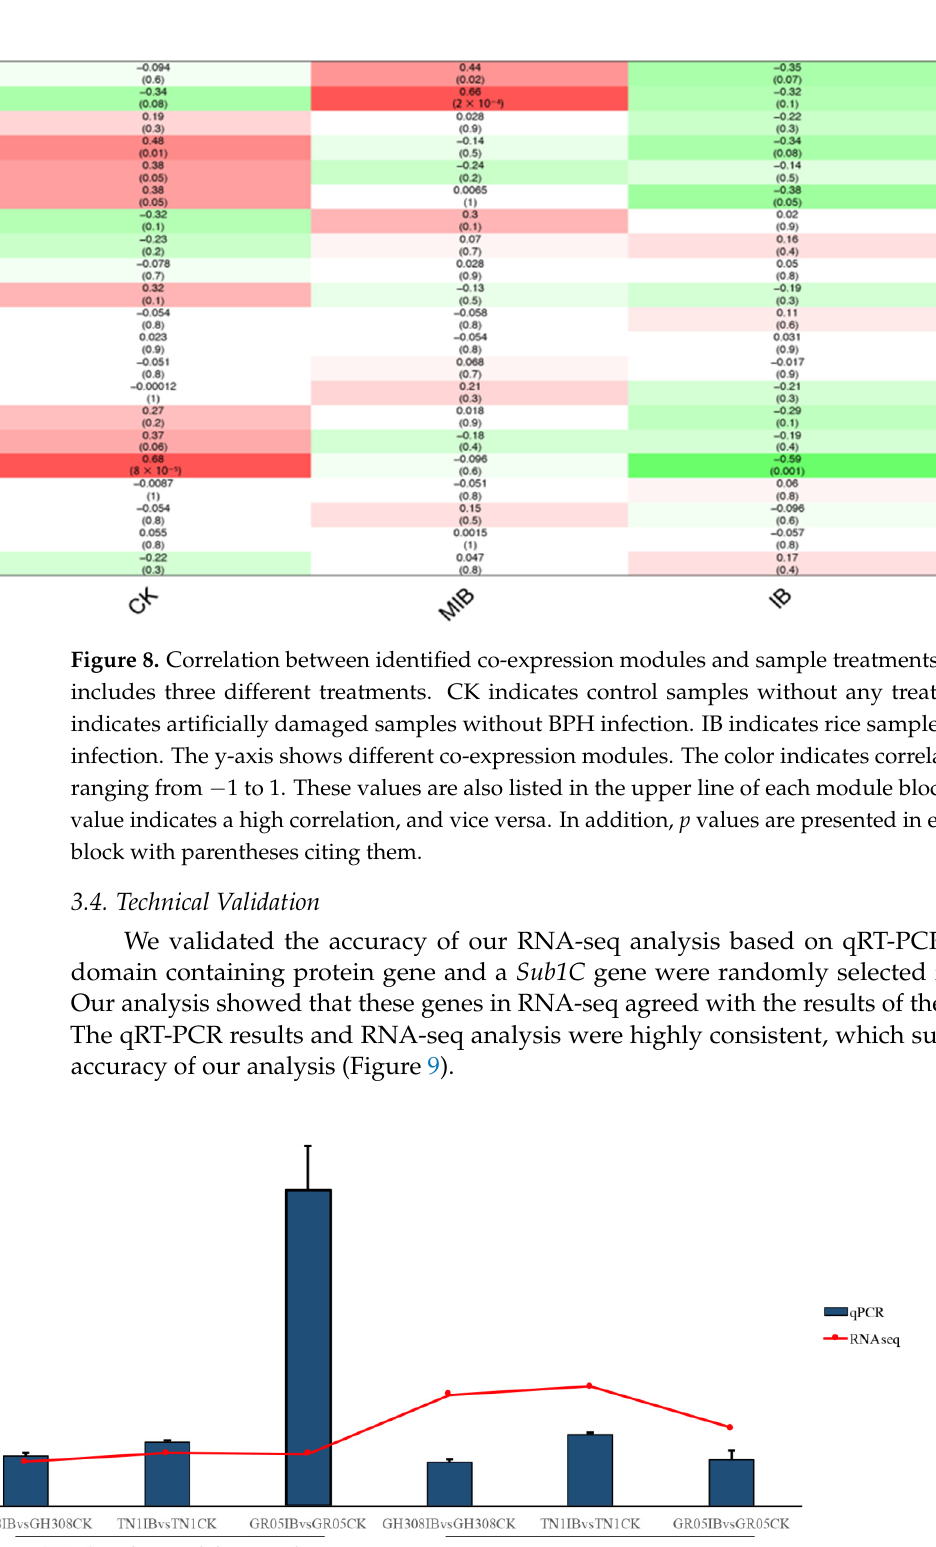
Figure 7. WGCNA co-expression analysis of 27 rice samples. The upper panel shows gene clusters based on their expression patterns. Genes that cluster in the same clade share a similar expression pattern. The gene clusters are further indicated using different colors in the lower panel.